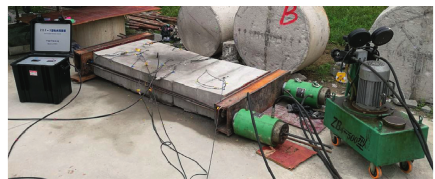
Figure 3: Model 1 field test using ZDF-3 electric spark source to generate stress